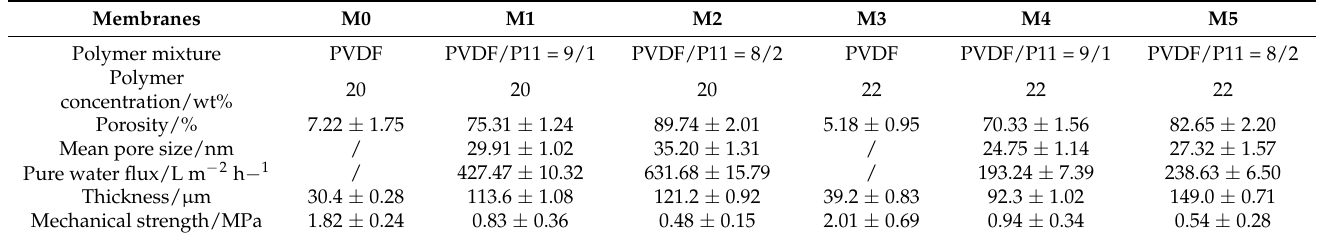
Table 1. The casting solution composition and general properties of the